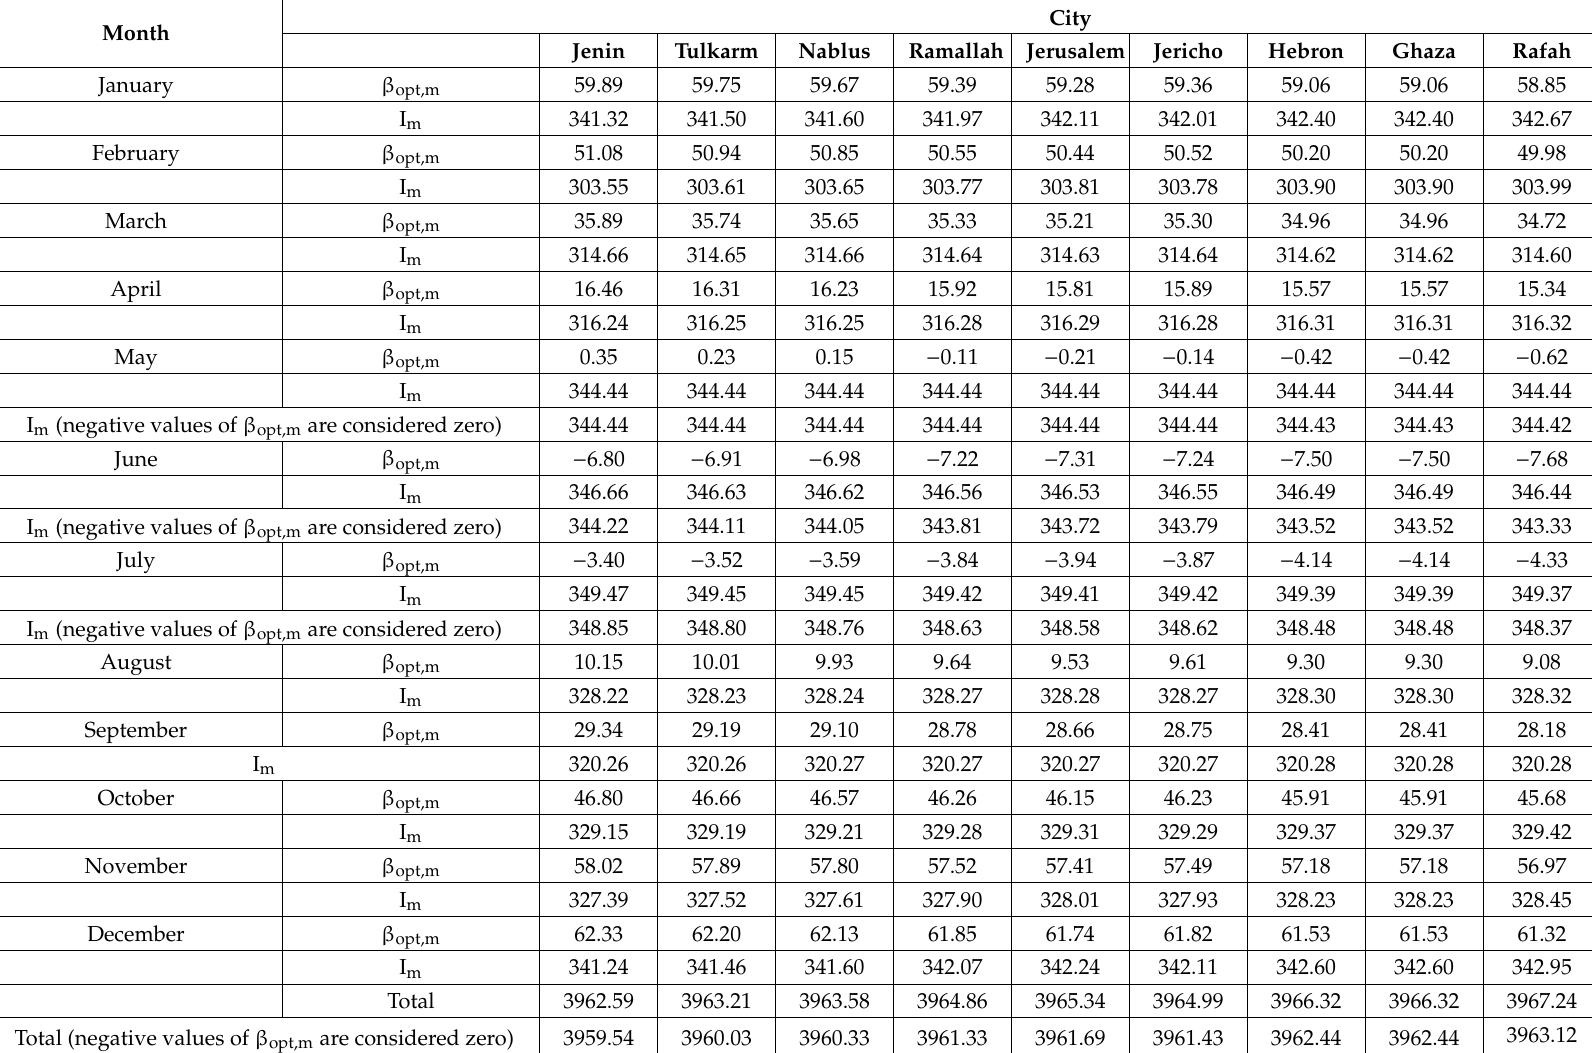
Table 5. The monthly optimum tilt angle β opt,m and extraterrestrial radiation I m in kWh / m 2 for the main Palestinian